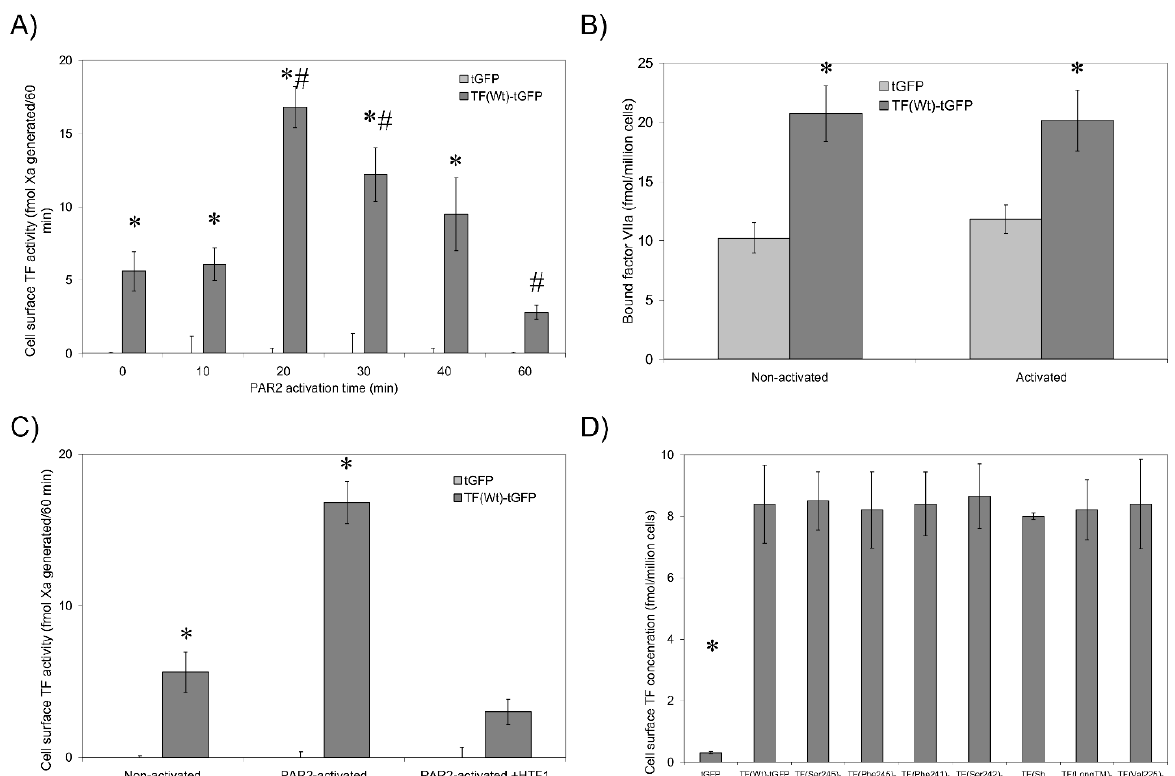
Figure 1. Analysis of TF-tGFP activity and fVIIa-HRP binding to TF. ( A ) The ability of HDBEC (5 × 10 4 ) expressing either TF-tGFP or tGFP to support fXa-generation was measured before and after activation of the cells with PAR2-AP (20 µM) for up to 60 min. ( n = 10, * = p < 0.05 vs. non-activated cells expressing tGFP; # = p < 0.05 TF Wt -tGFP samples vs. non-activated cells expressing TF Wt -tGFP.) ( B ) HDBEC were incubated with fVIIa-HRP (20 nM) for 10 min and washed, and the amount of bound fVII-HRP was determined using HRP substrate. ( n = 3, * = p < 0.05 vs. respective cells expressing tGFP.) ( C ) HDBEC were pre-incubated with the inhibitory TF antibody HTF1 (40 µ g/mL) prior to analysis using the fXa-generation assay. ( n = 3, * = p < 0.05 vs. respective controls expressing tGFP.) ( D ) The expression of TF variants on the surface of the